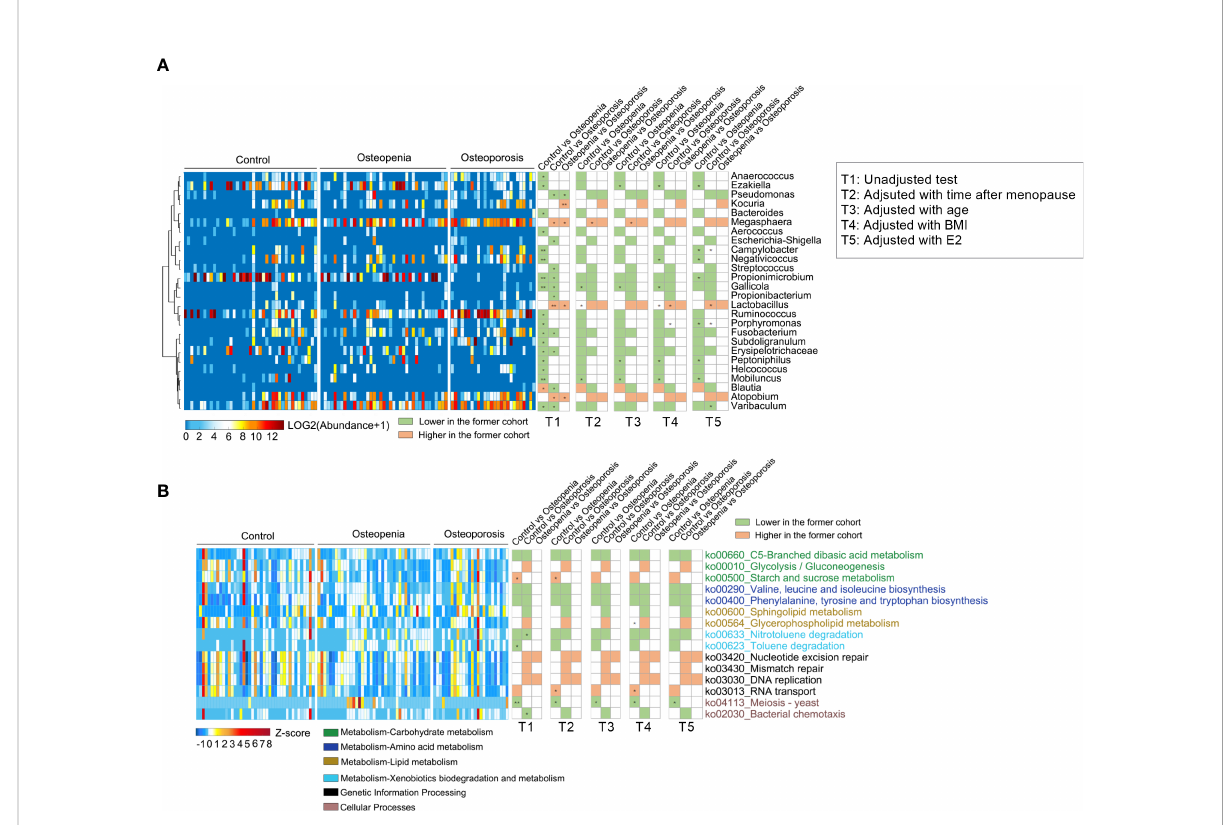
FIGURE 4 Different genera and KEGG pathways of VM among the control, osteopenia, and osteoporosis groups. (A) Different genera in the VM. The cluster of genera based on Spearman correlation coef fi cients is shown on the left. The heatmap in the middle shows the relative abundance (log2 transformed) of each genus in individual samples. Comparisons of the genera are shown in the right columns of the heatmap. All the genera were tested using Wilcoxon rank-sum test and adjusted to FDRs. * and ** represent FDR < 0.05 and < 0.01, respectively. (B) Differential predicted KEGG pathways. The heatmap in the middle shows the relative abundance (Z-score) of pathways in individual samples. All the pathways were tested using Wilcoxon rank-sum test and adjusted to FDRs. * and ** represent FDR < 0.05 and < 0.01,